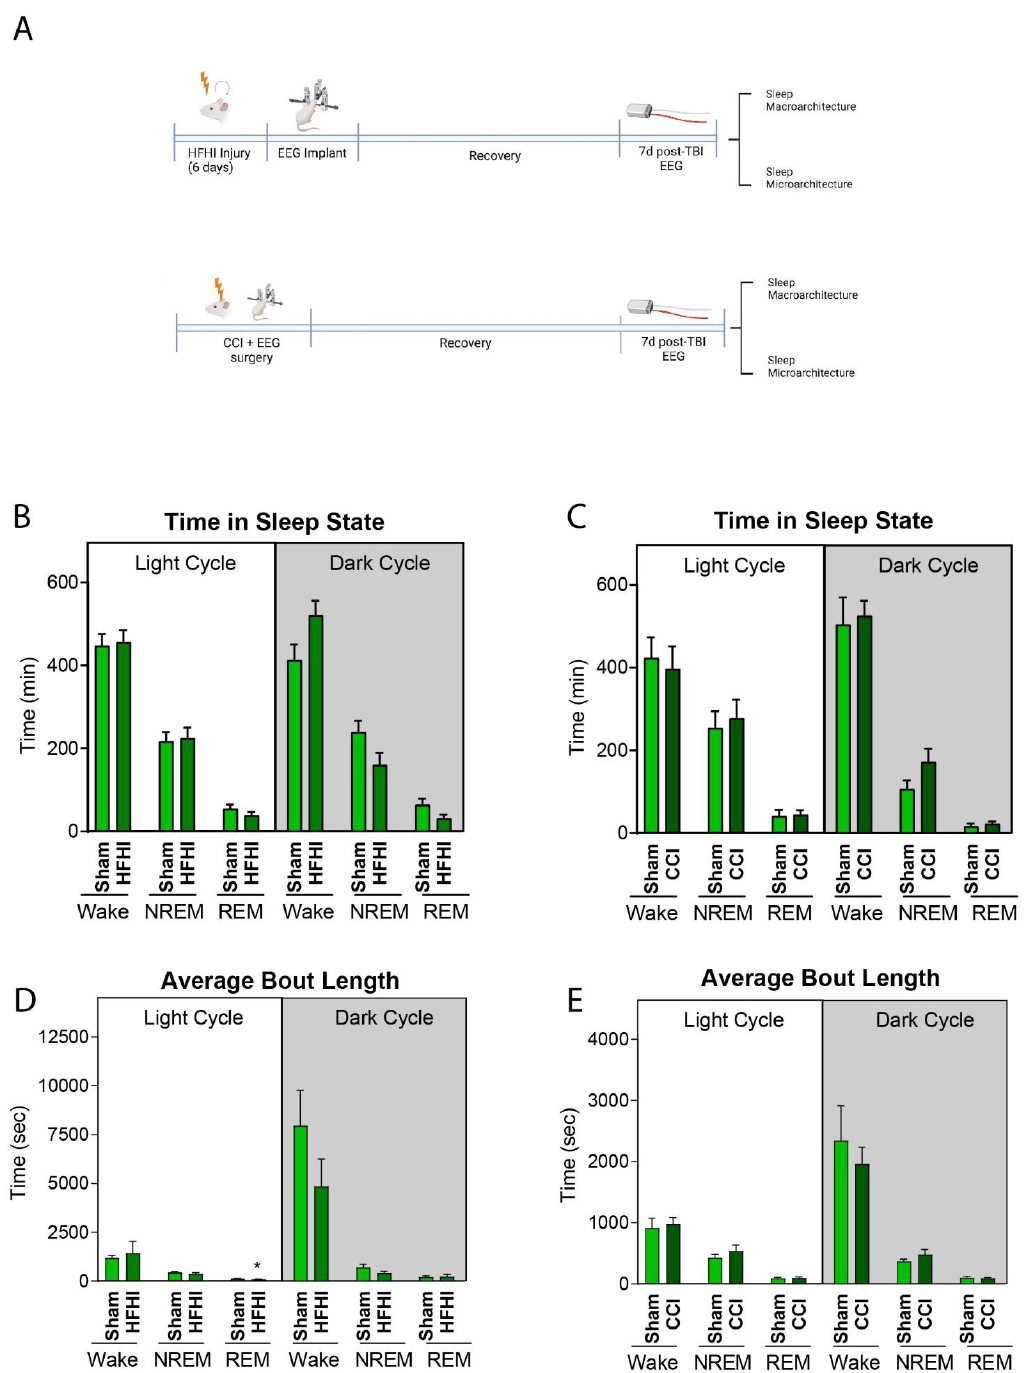
Figure 5. The effect of HFHI and CCI on sleep macro-architecture at 7 d post-injury. ( A ) HFHI and CCI mice were implanted with EEG/EMG telemetry devices and recorded for 24 h in normal 12:12 L:D conditions at 7 d post-injury. ( B ) HFHI caused no change to the amount of time spent in wake, NREM or REM during either the light cycle or the dark cycle. ( C ) CCI caused no difference in the amount of time spent in wake, NREM or REM during either the light cycle or the dark cycle. ( D ) HFHI caused a significant decrease in the bout length of REM during the light cycle compared to sham, but no change in the bout length of wake or NREM. There were no differences in the bout length of wake, NREM or REM during the dark cycle in HFHI mice. ( E ) CCI caused no difference in the average bout length of wake, NREM or REM during either the light cycle or the dark cycle. Unpaired t -test, * p = 0.048, n = 8 sham, 8 HFHI and 8